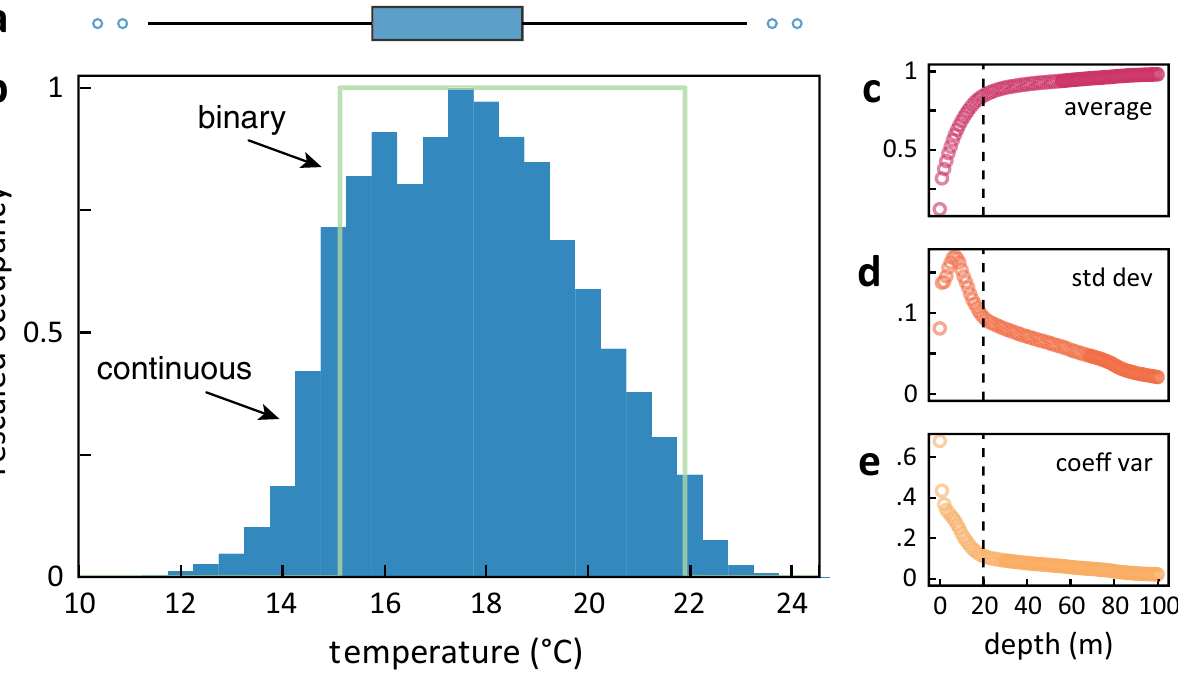
Figure 2. Derived thermal suitability of juvenile white sharks from time-depth recorders. All data are derived from onboard sensors from electronic tags on 14 juvenile white sharks deployed from 2001 to 2019 in southern and central California (Table S1, Figure S1). a Summary boxplot where the blue box is the core 50% interval, whiskers are the 95% interval, and hollow circles are extreme temperature values. b Binary (green line) and continuous model (blue histogram) of thermal occupancy. Binary model is the realized thermal limit based on the occupancy-weighted 95% interval (15.1–21.9° C). The continuous model reports thermal occupancy continuously, rescaled from the time-at-temperature histogram (Figure S4), here binned every 0.5° C. a,b were calculated from temperatures sensed at 0–20 m depths, a criterion determined from the natural breaks in the c average, d standard deviation and e coefficient of variation of time-at-depth between individual sharks.